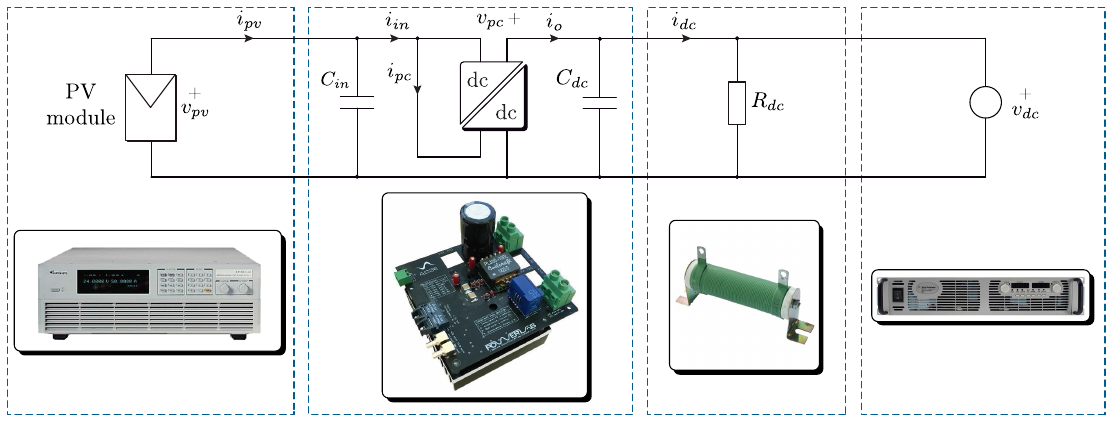
Figure 4. Experimental test bench for the evaluation of the proposed